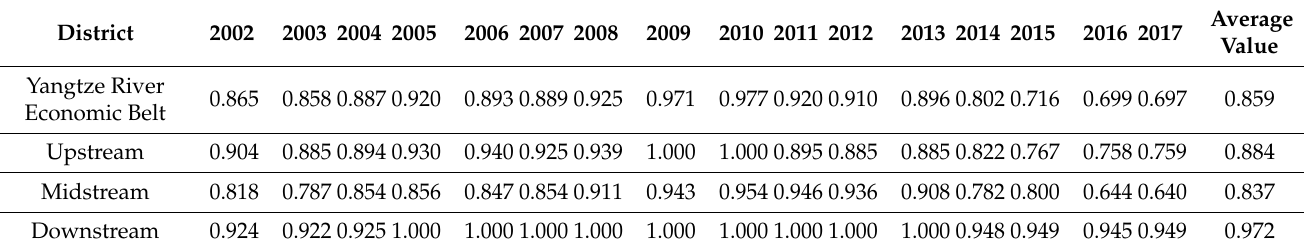
Table 2. Green efficiency of water resources in the Yangtze River Economic Belt as a whole, and by region, for 2002–2017.